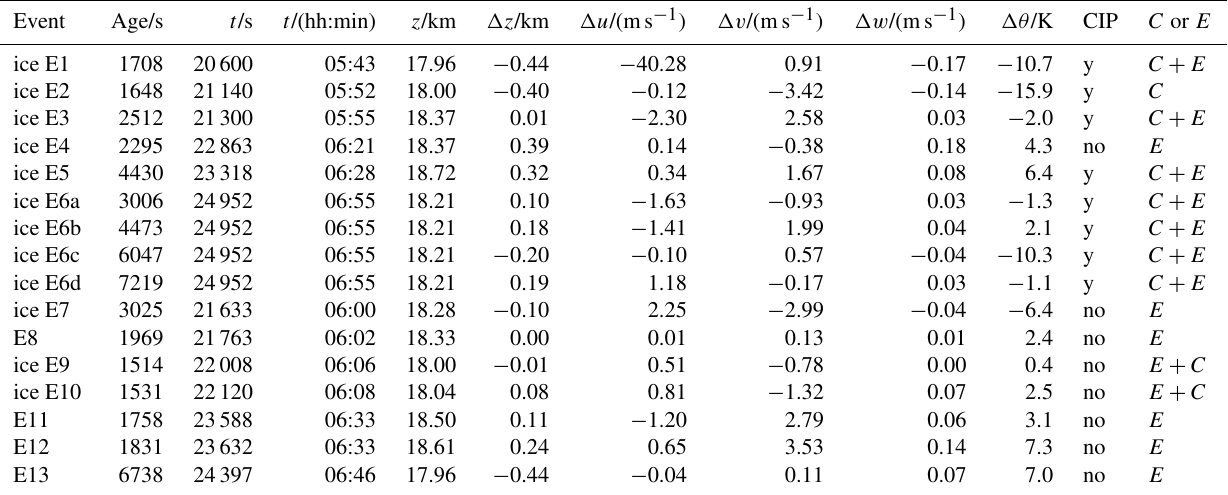
Table 4. Potential plume self-encounters (for symbols see text), with classification as convective ( C ) or exhaust ( E ) event, 30 November 2005.